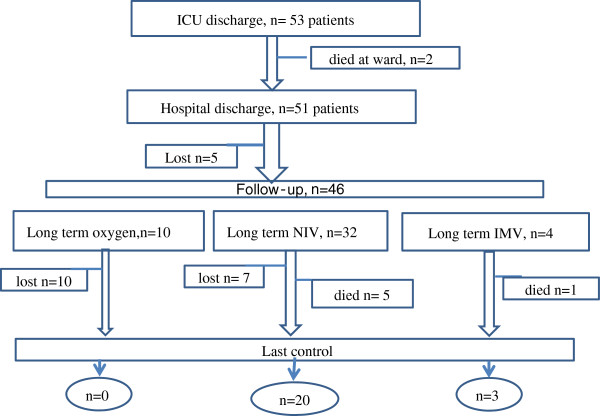
 Follow-up outcomes of kyphoscoliosis patients.